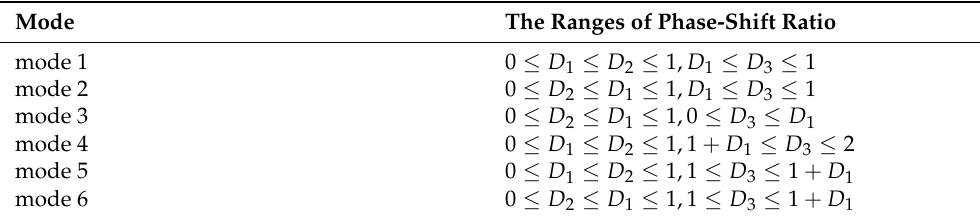
Figure 2. AC output voltage waveforms in different modes of TPS control: ( a ) mode 1, ( b ) mode 2, ( c ) mode 3, ( d ) mode 4, ( e ) mode 5, ( f ) mode 6. Table 1. The ranges of phase-shift ratio under TPS